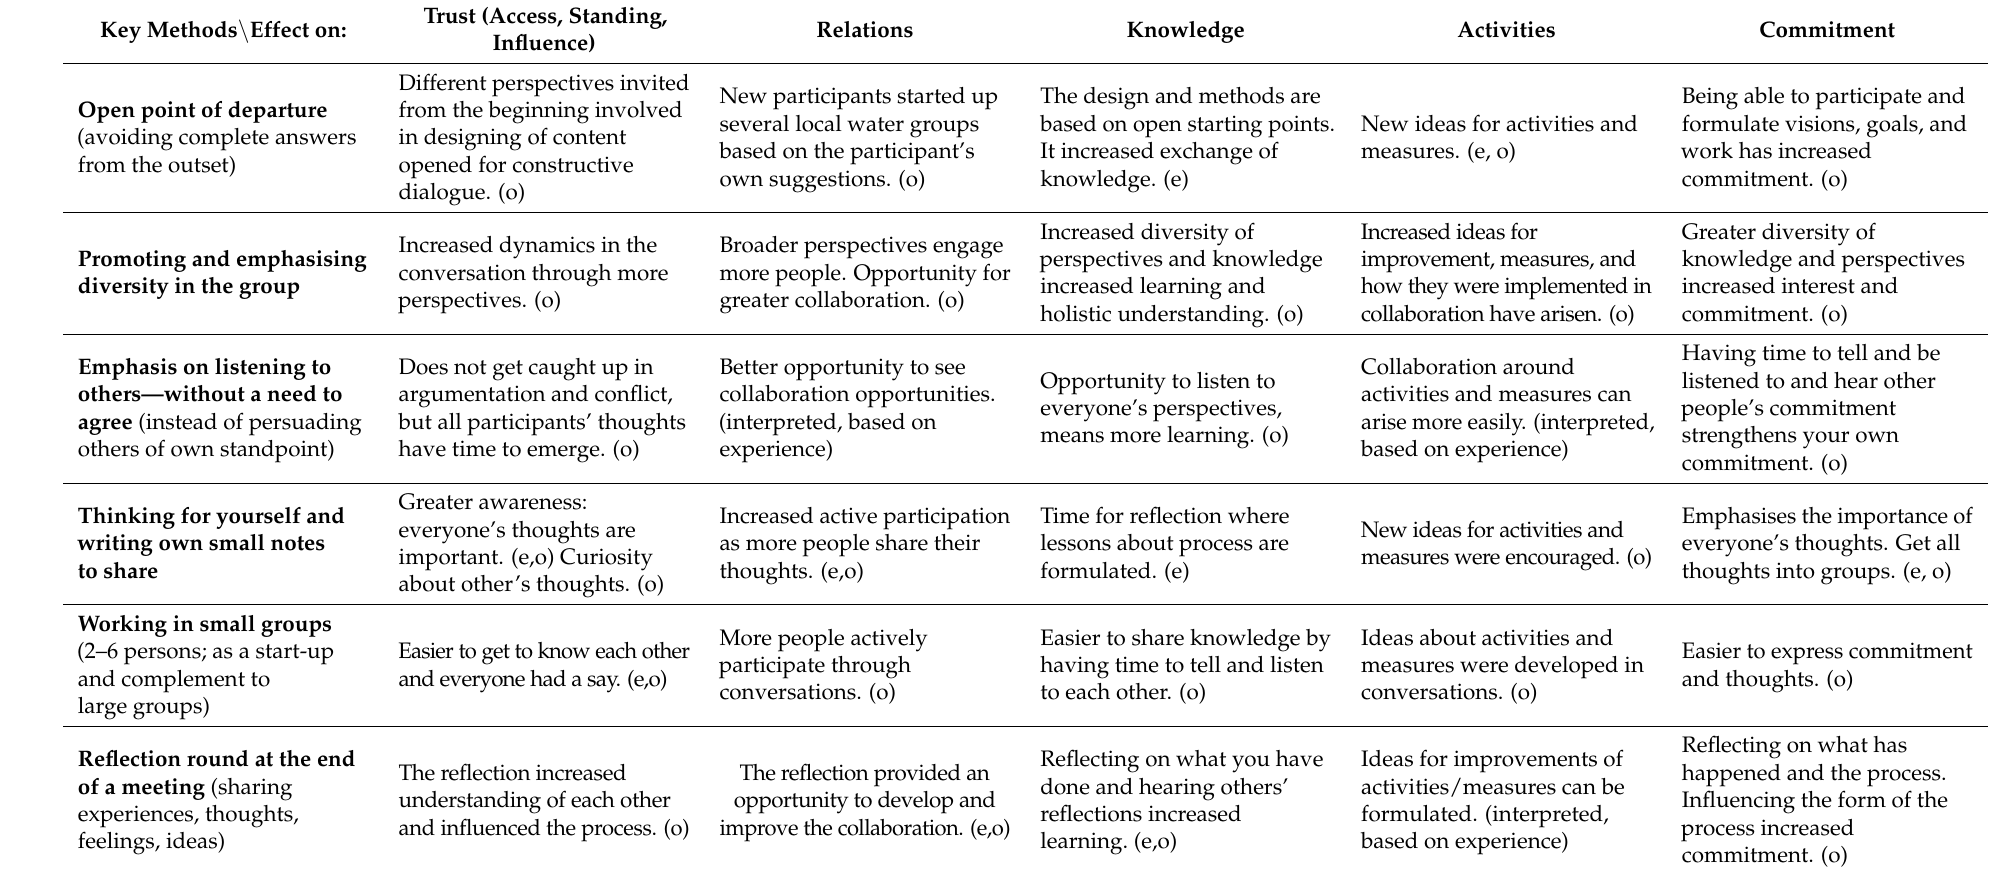
Table 5. Results: Key examples of basic participatory methods as a part of CSS used in the process and their